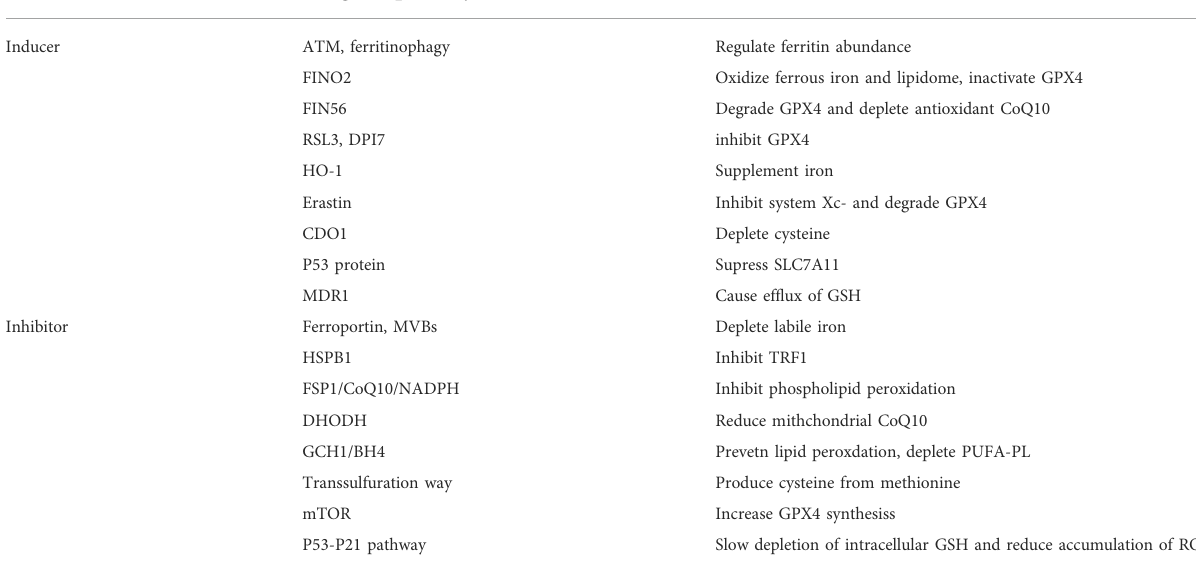
TABLE 1 Inducers and inhibitors of